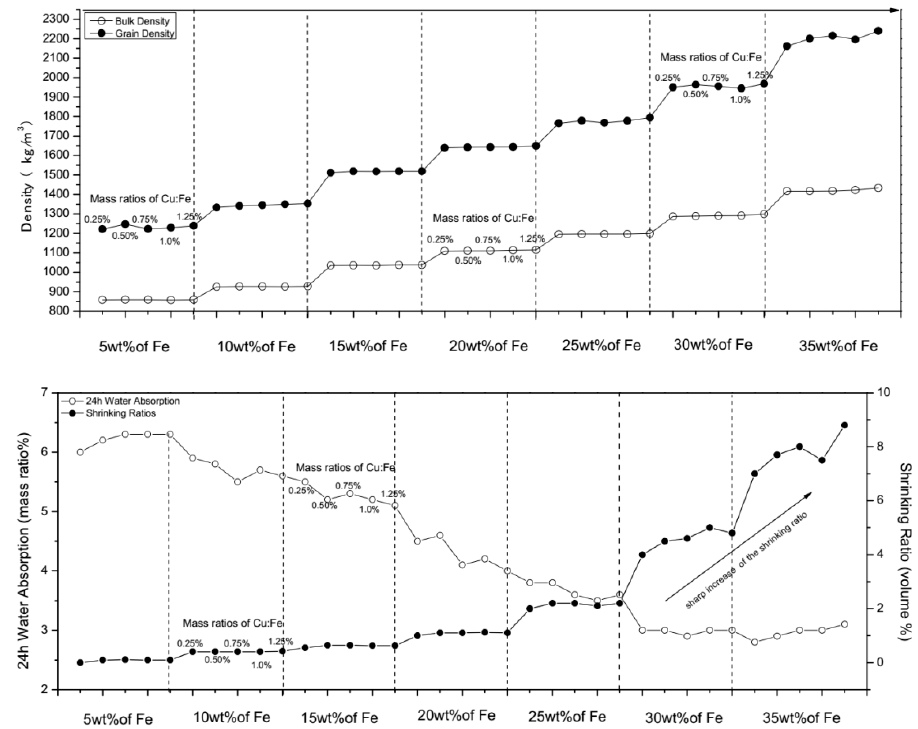
Figure 1. Bulk density, grain density, 24 h water absorption and shrinking ratio test of CCF (Copper Carbon Fe Catalyst).